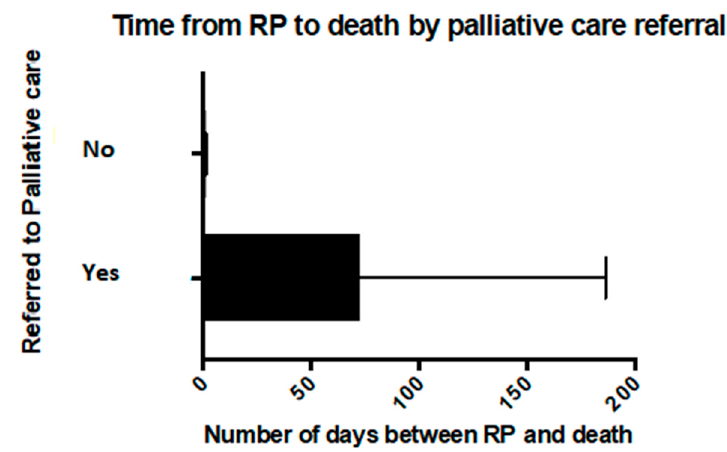
Figure 4. Time from development of RP to death by palliative care referral.